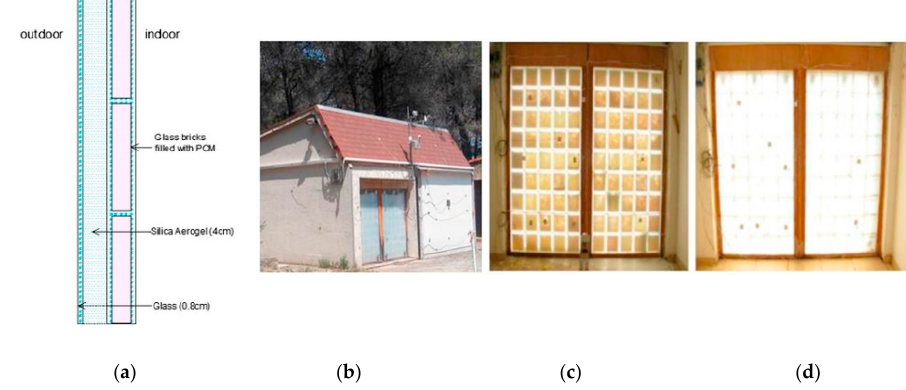
Figure 12. ( a ) Insulated translucent wall components, ( b ) outside view, and inside view in ( c ) solid and ( d ) liquid phases of the PCM [46].